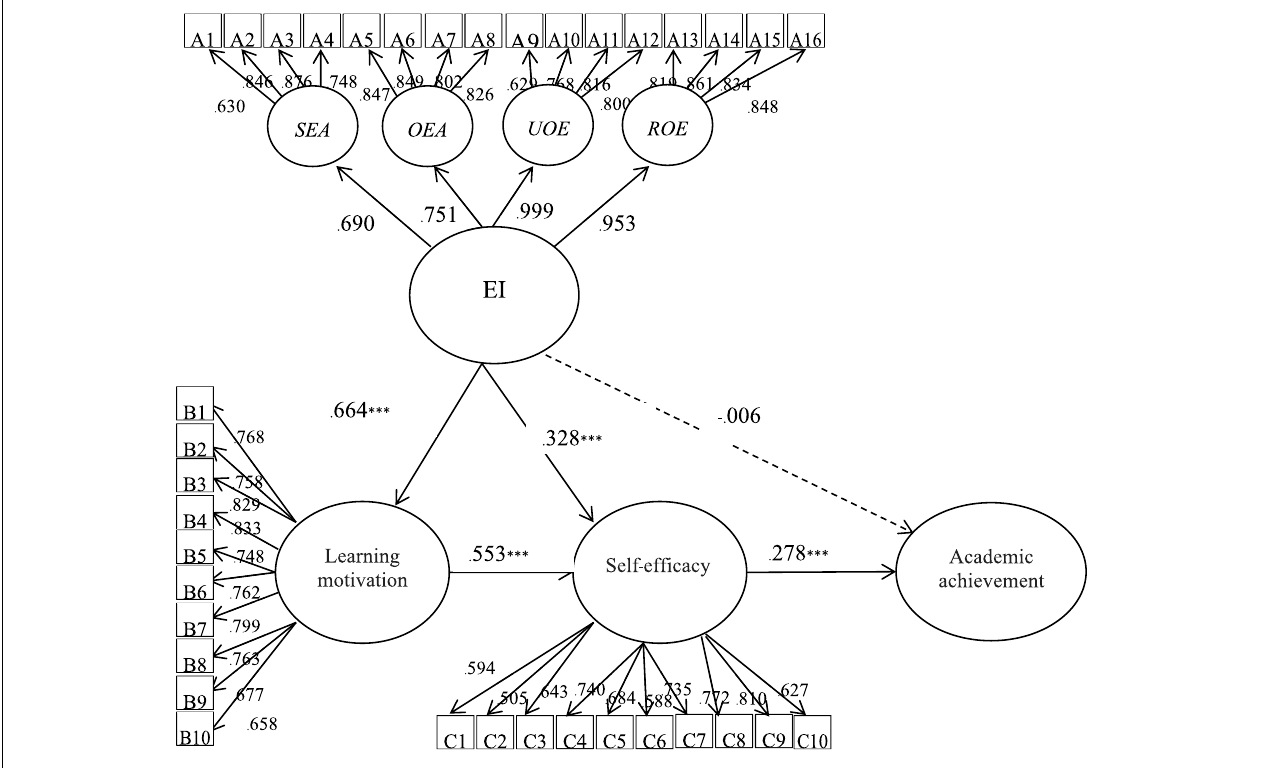
FIGURE 1 | SEM path analysis. SEA, self-emotion appraisal; OEA, others’ emotional appraisal; UOE, use of emotion; ROE, regulation of emotion. *** p < 0.001.